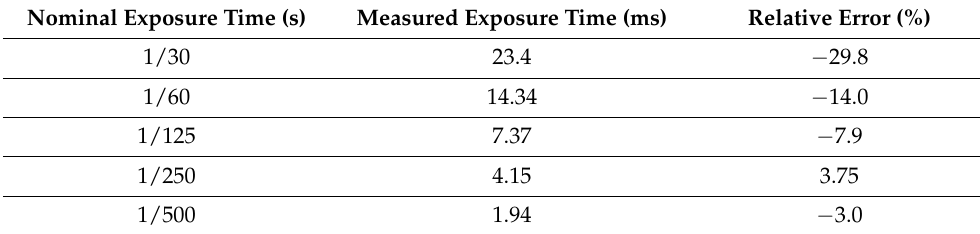
Table 2. Measurement results of C1, with the direct measurement.